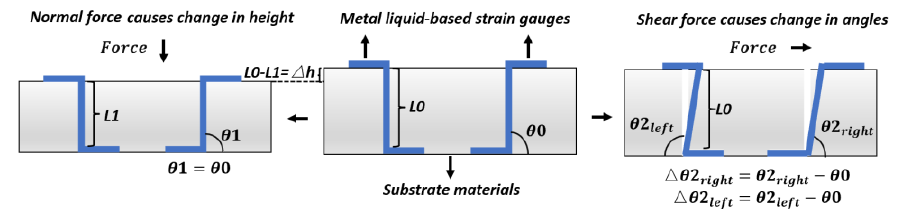
Figure 3. Response of metal liquid gauges under shear and normal forces [19,33]. Normal force causes vertical gauge strain, which is reflected in response height. Shear force causes gauge incline, which is reflected in response angle [31].